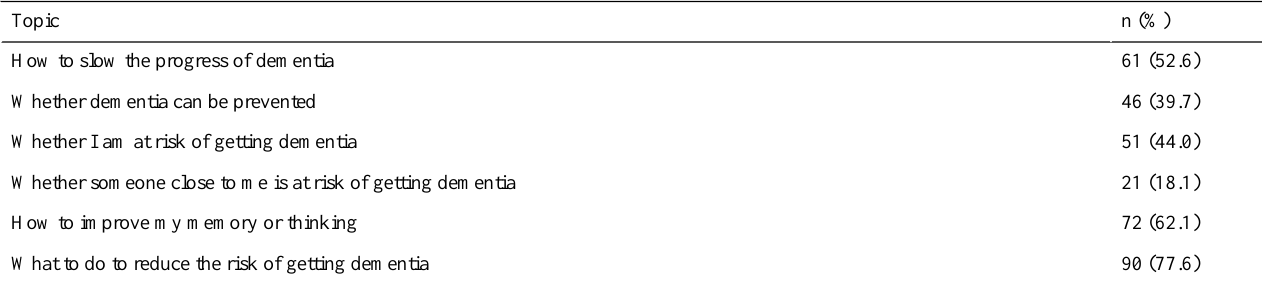
Table 4. Proportion of respondents who selected the given options for what they hoped to learn from the website